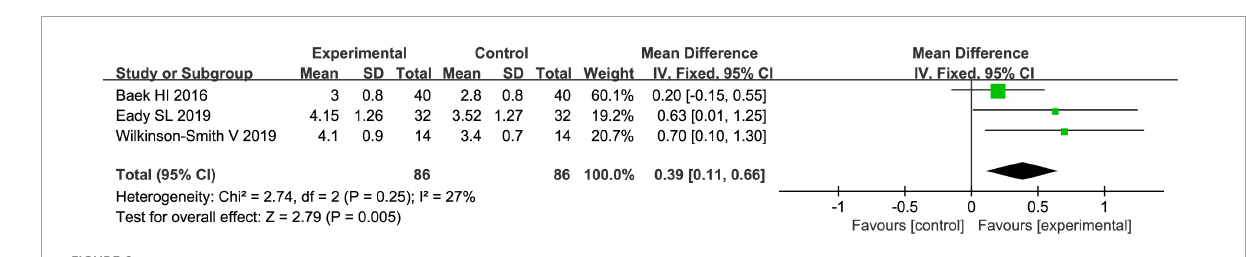
FIGURE6 Effect of fruit intervention on the Bristol stool score in the fixed-effect meta-analysis.